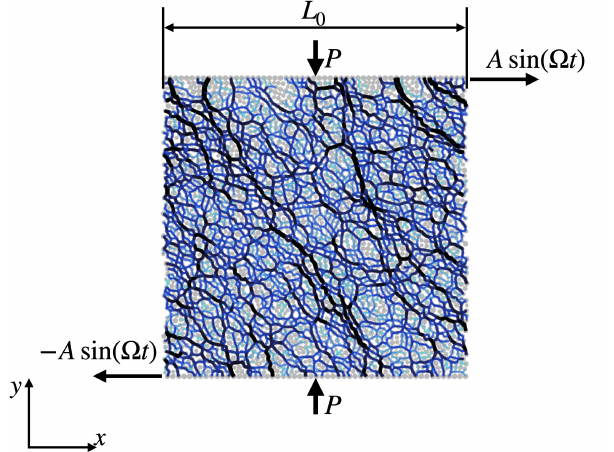
Figure 1. A snapshot of our simulated system, where P , A and Ω are the pressure, strain amplitude, and angular frequency of oscil- lation, respectively. The circles and lines represent the particles and contact network of particles, respectively. The thickness of each line is proportional to the magnitude of the contact